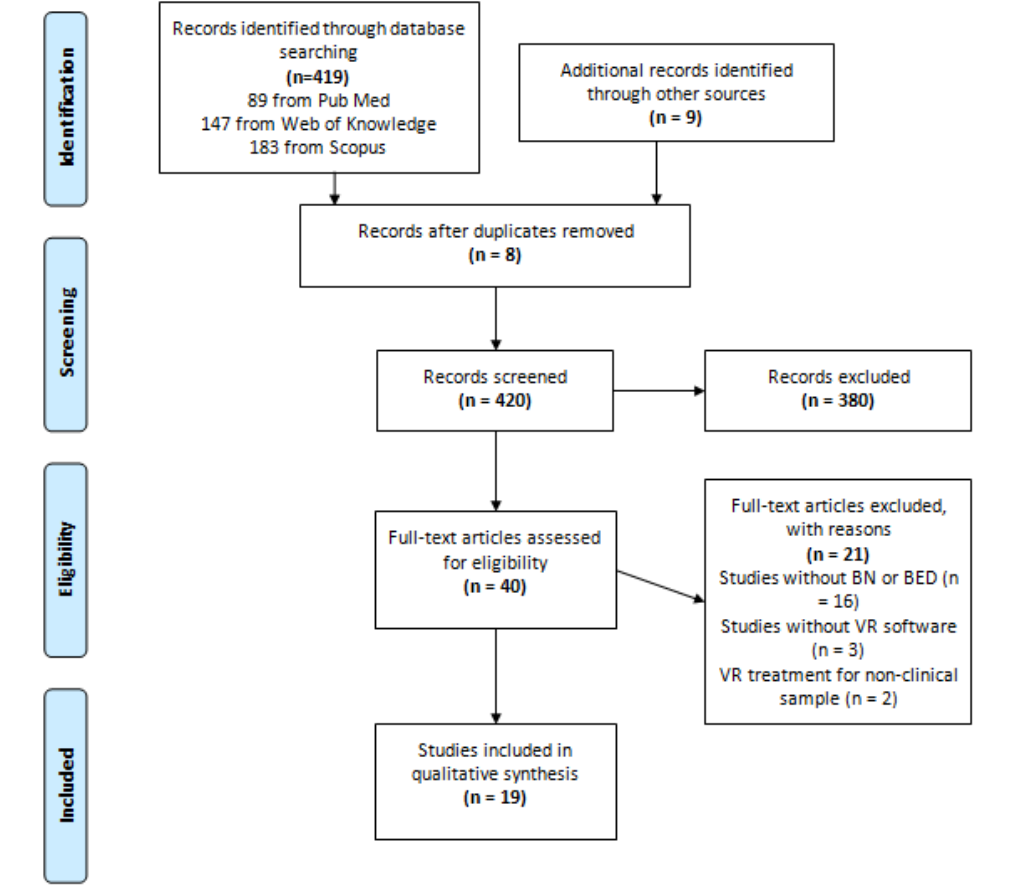
Figure 1. PRISMA Flow Diagram.